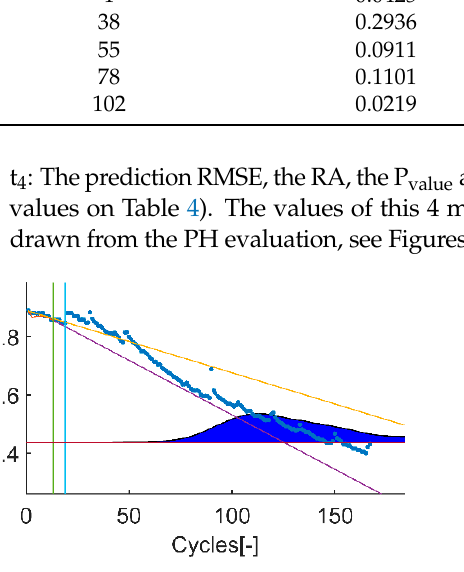
Figure 9. Time-instant figure of test 1 on t 4 .